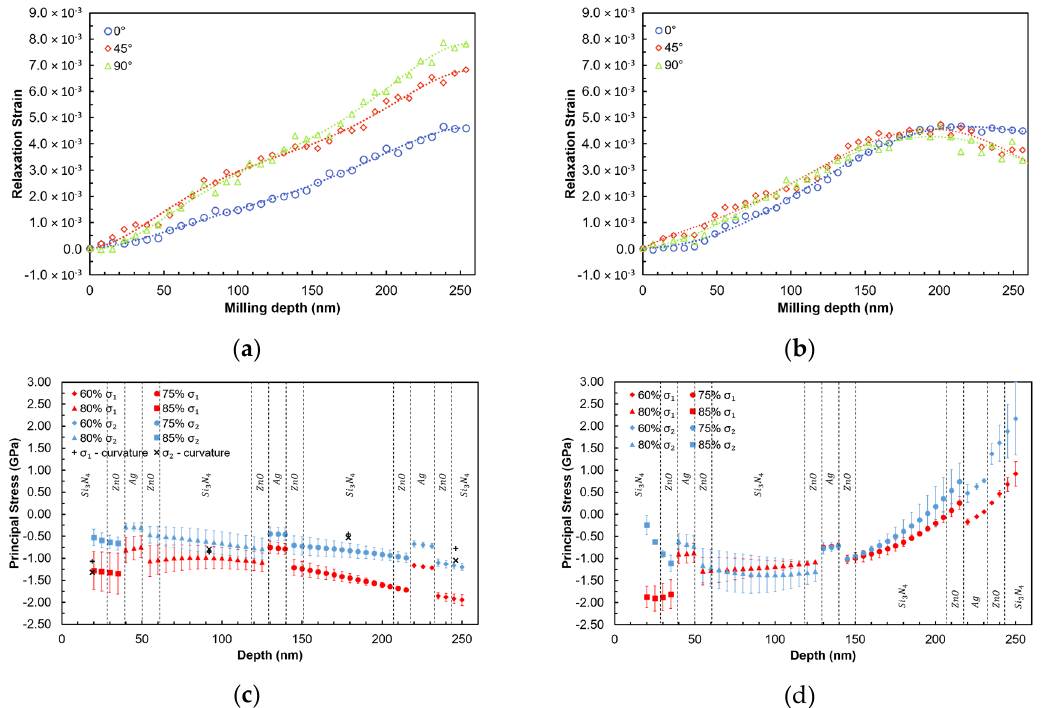
Figure 8. Relaxation strain (with fitting of polynomial function, grade 4) along three directions before Figure 8. Analysis of the surface residual stress gradient for the sample after heat treatment. heat treatment (examples for radius% = 80%) ( a ) and after heat treatment ( b ). Principal residual stress ( a ) Experimental relaxation strain (along one direction, as an example, where dashed lines represent profiles (σ1 and σ2) obtained by considering multiple radius% , ( c ) before the heat treatment cycle and the polynomial interpolation) for di ff erent values of radius% ; ( b ) Corresponding residual stress profiles (second principal stress, as an ( d ) after the heat treatment cycle. (Dashed lines indicate the different layers of the films, according to the architecture described in Section 2.2).